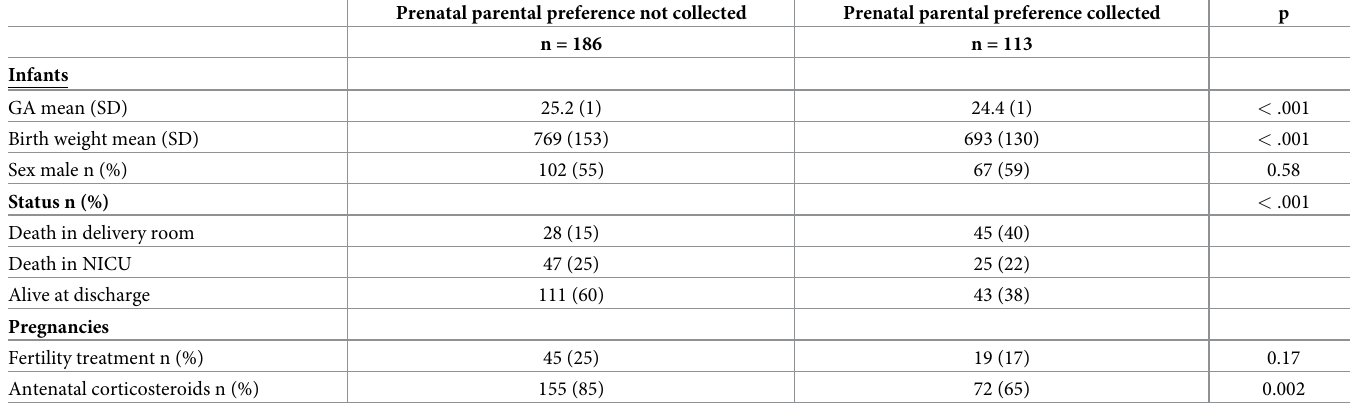
Table 1. Characteristics of infants and pregnancies according to whether a parental preference was collected prenatally.